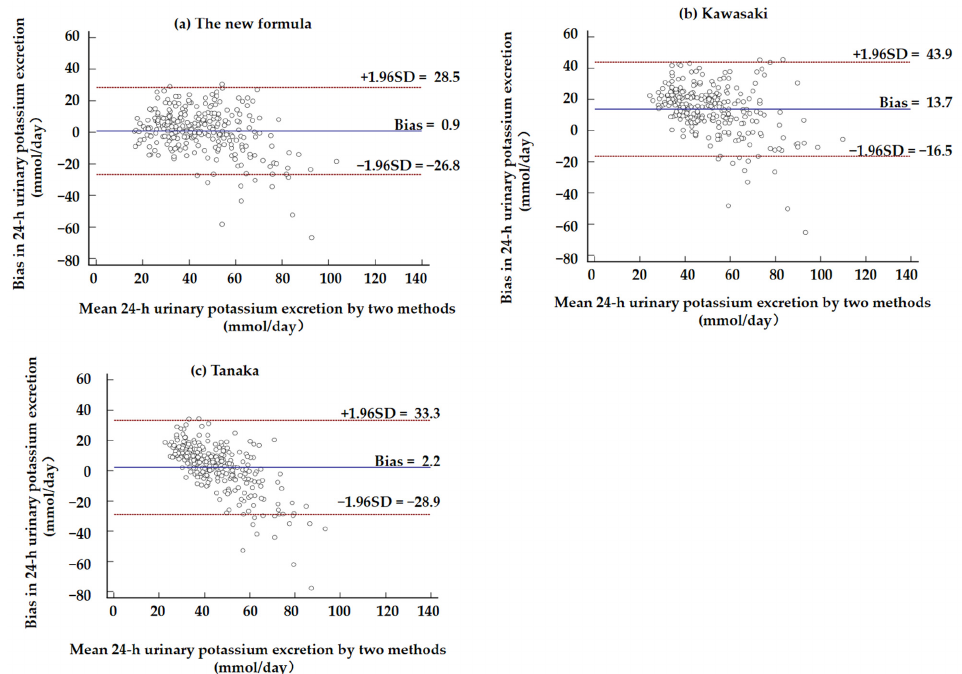
Figure 3. Bland–Altman plots showing the difference in 24 h urinary potassium excretion (24UKV) between measured and estimated values from the new formula ( a ), Kawasaki formula ( b ), and Tanaka formula ( c ). The difference was calculated as the estimated values minus the measured values. The middle line is the mean bias, while the upper and lower dashed lines are the upper and lower limits, respectively.